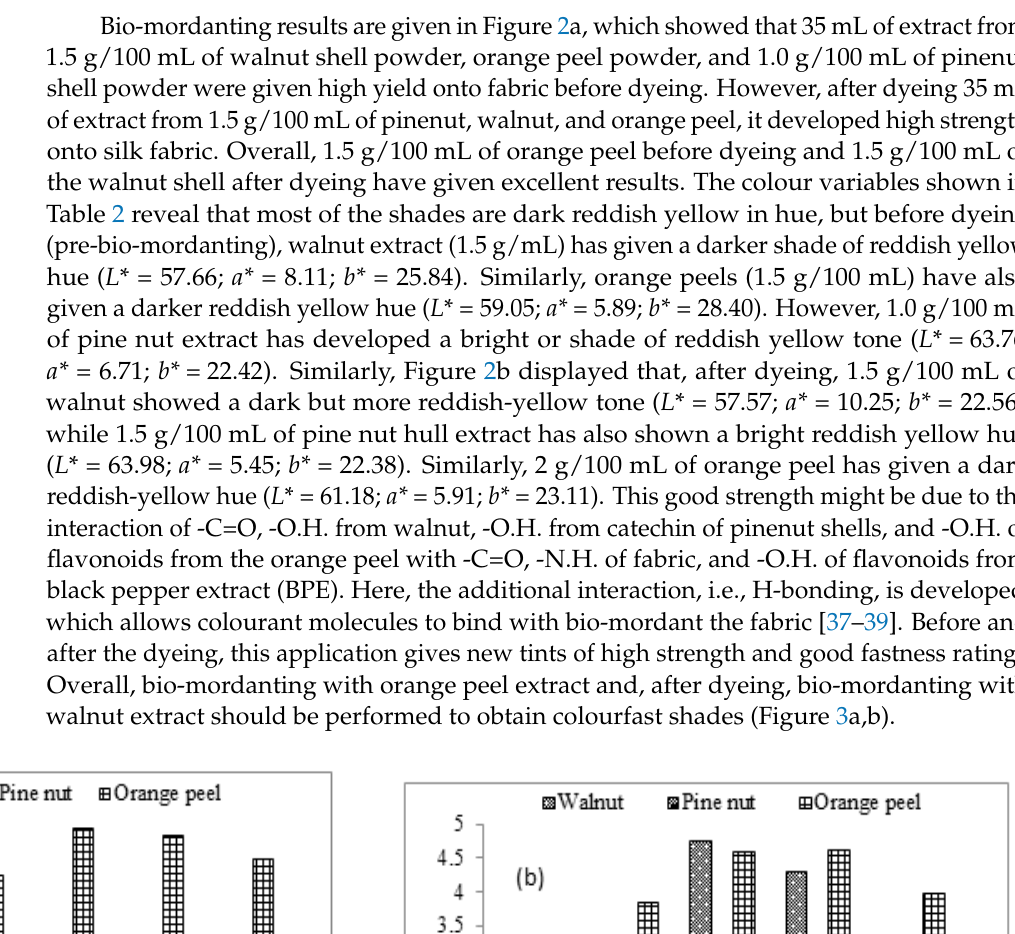
Figure 3. Pre-chemical ( a ) and post-chemical mordanting ( b ) of silk with black pepper extracts un- der selected conditions. Table 2. Colorfastness ratings of chemical mordant and bio-mordanted silk fabric dyed using an acid-solubilized extract of black pepper. Pre-Mordanting Mordant Name Mordant Conc. %